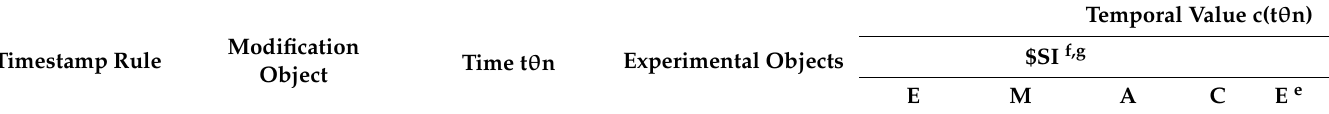
Table 7. Functional reconstruction on cover media modification (Stage